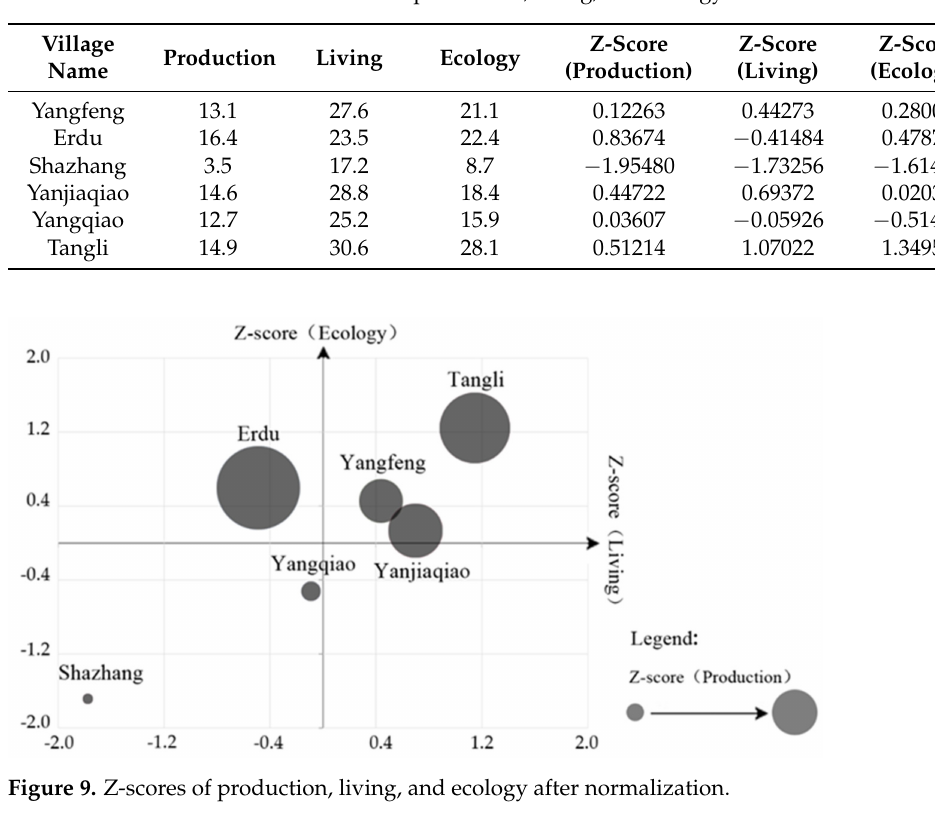
Table 6. Z-score normalization results of production, living, and ecology.